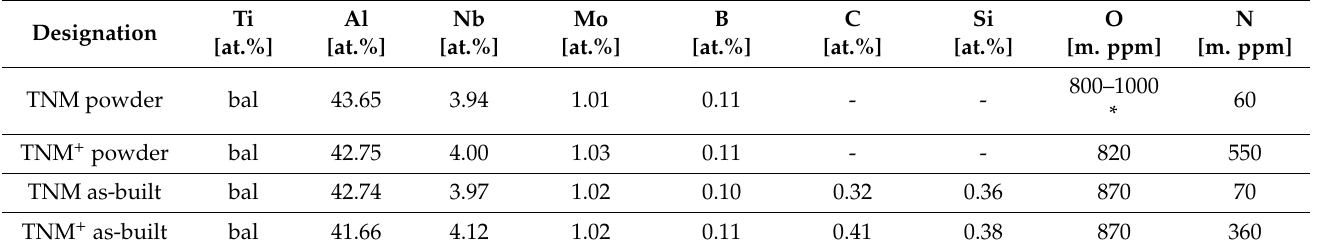
Table 1. Chemical composition of the feedstock powder and the LPBF-fabricated specimens of the TNM and TNM + alloy in at.% and m. ppm, respectively (see